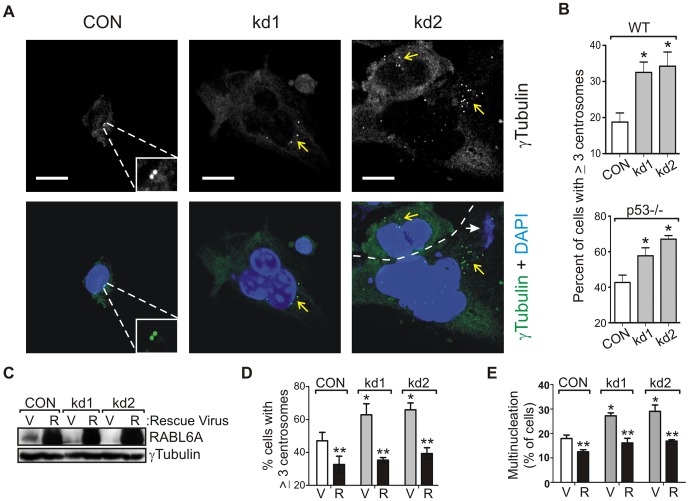
RABL6A knockdown causes centrosome amplification in WT and p53−/− MEFs.(A) Representative confocal images taken under identical settings of p53−/− CON, kd1 and kd2 cells stained for centrosomes (γ-tubulin, green) and nuclei (DAPI, blue). Yellow arrows point to areas with centrosomes, white arrows indicate micronuclei. Dashed line in the kd2 image demarcates two different cells. Scale bar, 20 µm. (B) Quantification of immunofluorescence data from (A) measuring the percent of cells with > 3 centrosomes per cell. *, p<0.05 versus CON. (C) Immunoblot showing effective mouse RABL6A depletion in p53−/− MEFs, as well as high level overexpression of human RABL6A, with γ-tubulin levels as loading control. (D and E) Quantification of immunofluorescence data for centrosome amplification (D) and multinucleation (E) in CON, kd1 and kd2 p53−/− MEFs expressing empty vector (V) or human RABL6A (R) rescue viruses. The mean values plus standard deviations were obtained from more than 3 independent experiments (*, p<0.001 compared to CON; **, p<0.01 for human RABL6A expressing cells compared to vector controls). Statistical significance for data in panels B, D and E was determined using paired, two-tailed Student’s t-test.